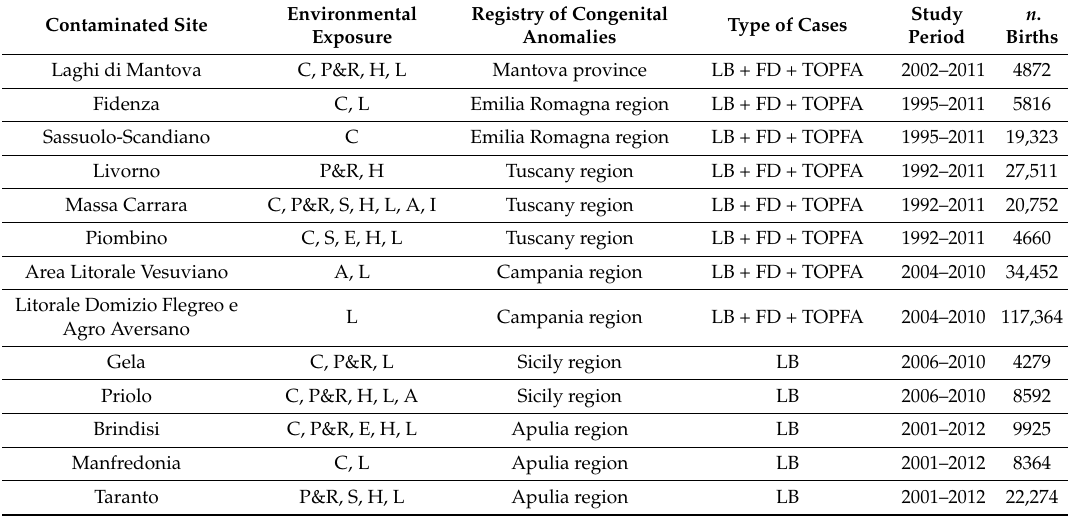
Table 1. Contaminated sites, sources of environmental exposure, registry of congenital anomalies, type of cases, study period, and number of